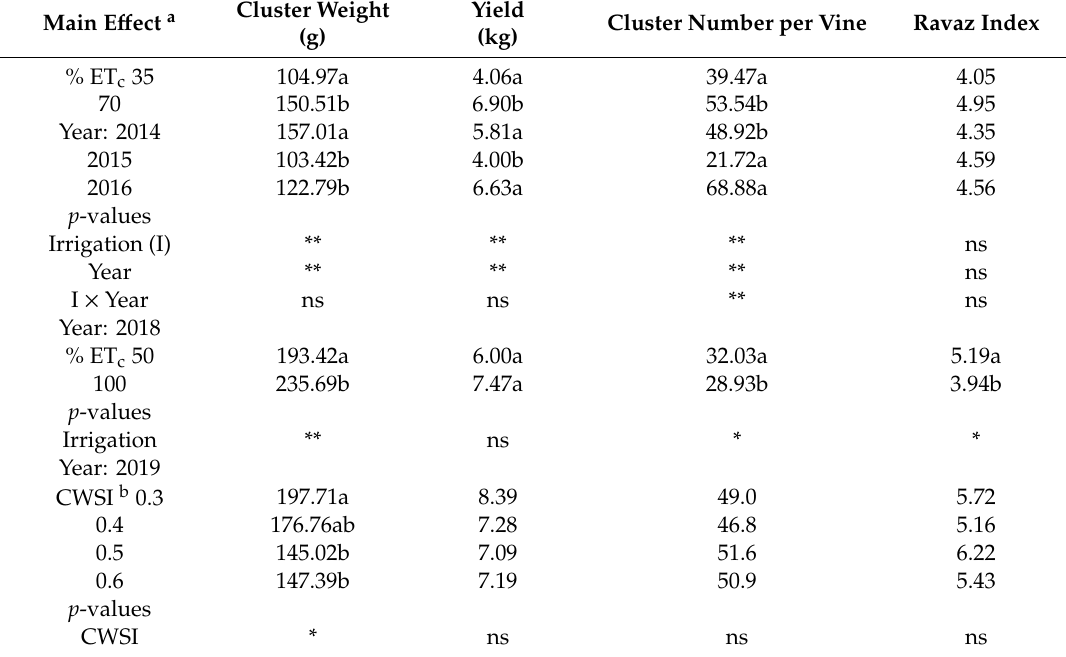
Table 3. Yield components for Malbec (MB) grapevines grown under semi-arid conditions in southern Idaho that were drip-irrigated at weekly intervals with di ff ering fractions of estimated water demand (ET c ) (2014, 2015, 2016, 2018) or irrigated with the same amount of water at di ff ering irrigation intervals (2019) based upon threshold daily crop water stress index ( CWSI ) values. Cluster Weight Yield Cluster Number per Main E ff ect a (g) (kg)